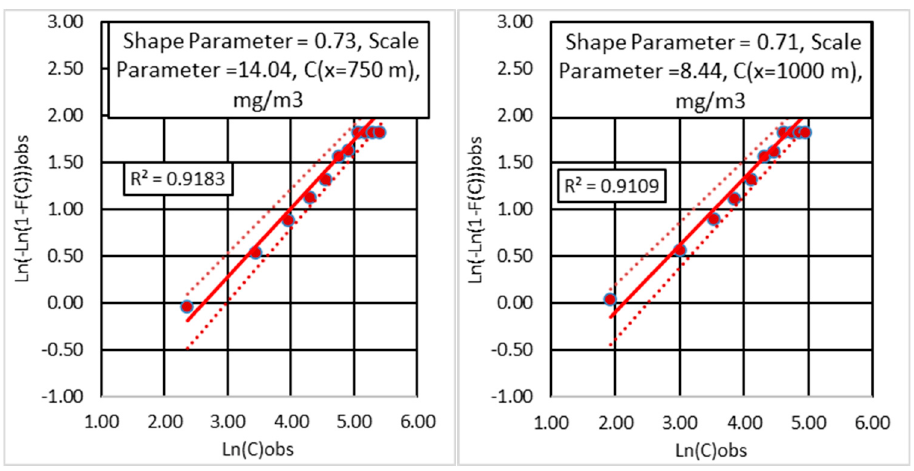
Figure 15. Weibull descriptors and lower and upper confidence level of air pollution concentration, x = 750 m ( left ) and x = 1000 m ( right ), NO x .